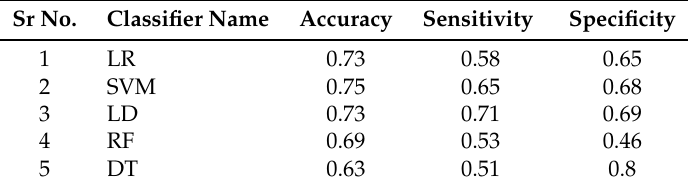
Table 5. 10-Fold Results based on the Top 90 Selected Features based on Proposed 3-Stage Approach. Sr No.